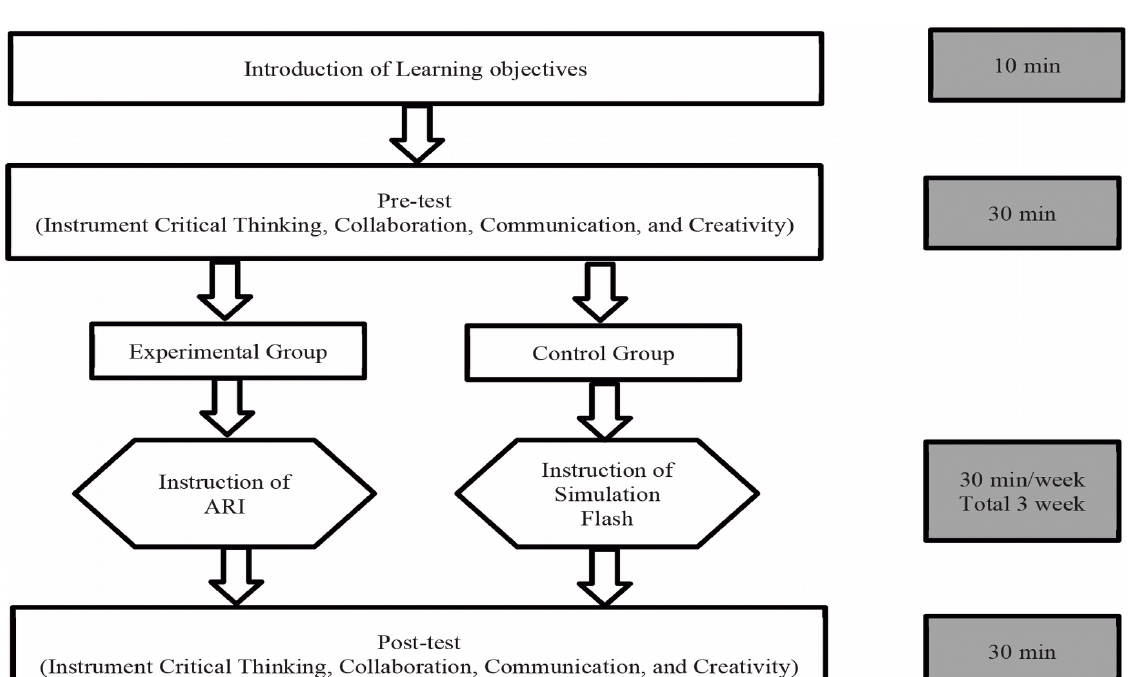
Figure 6. Experimental Research Procedure